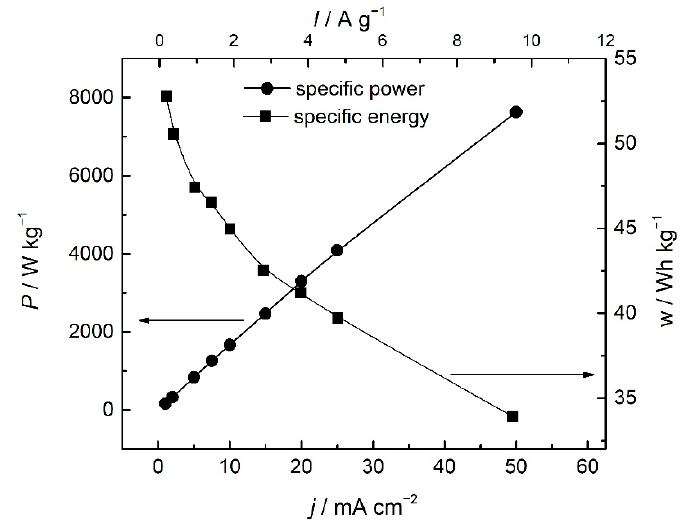
Figure 9. The dependence of specific power, P , and specific energy, w , of PANI vs. SCE on the dis- charge current.